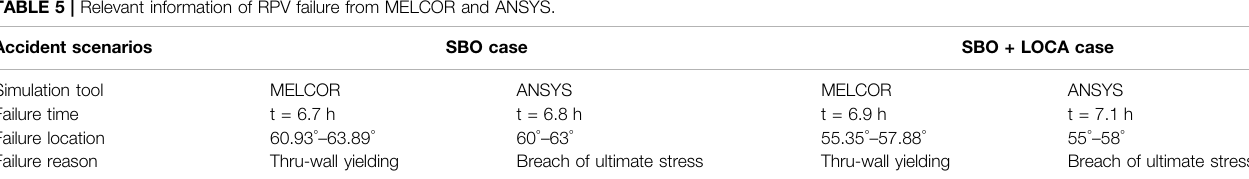
TABLE 5 | Relevant information of RPV failure from MELCOR and